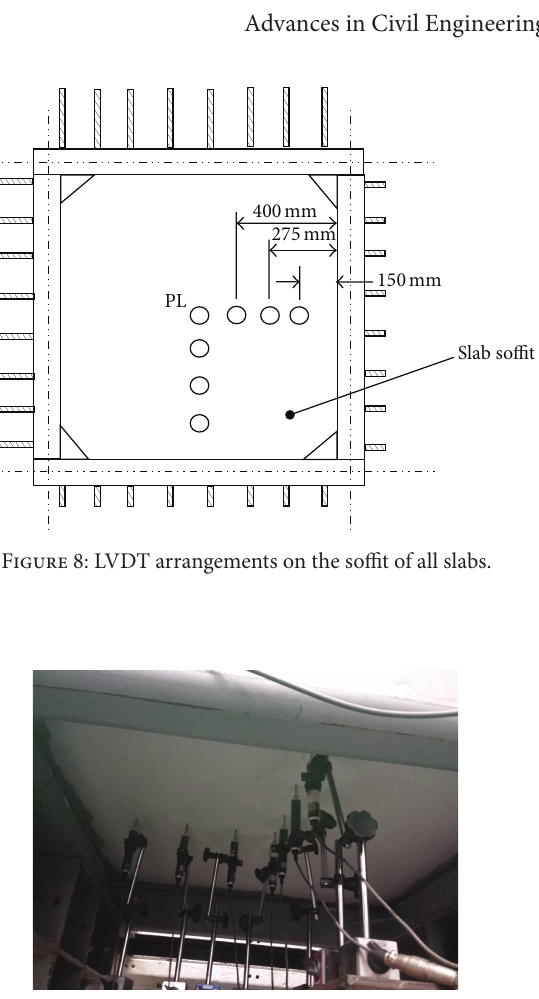
Figure 9: LVDTs positioned on the soffit of each slab.